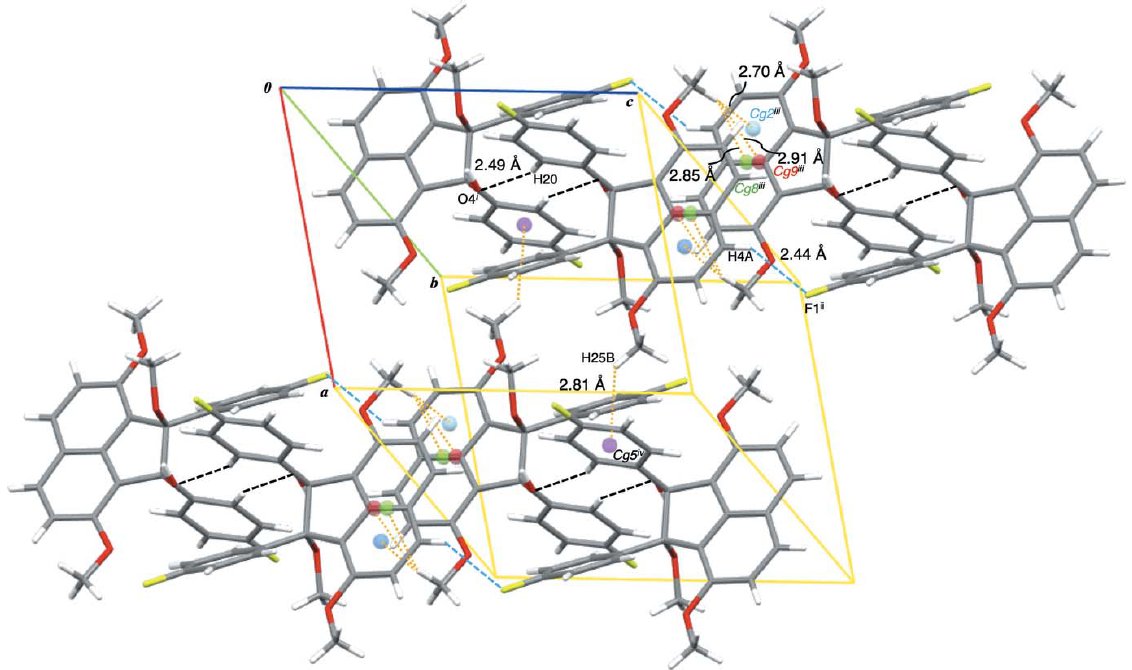
Figure 4 A view of the crystal packing of the title compound, showing the arrangement of the dimeric molecular units. Non-classical C—H (cid:2)(cid:2)(cid:2) F, C—H (cid:2)(cid:2)(cid:2) O and C—H (cid:2)(cid:2)(cid:2) (cid:2) hydrogen bonds are shown as blue, black and orange dashed lines, respectively [symmetry codes: (i) (cid:5) x , (cid:5) y + 1, (cid:5) z + 1; (ii) x , y , z + 1; (iii) (cid:5) x , (cid:5) y + 1, (cid:5) z + 2; (iv) x + 1, y , z ; centroids are defined in Table